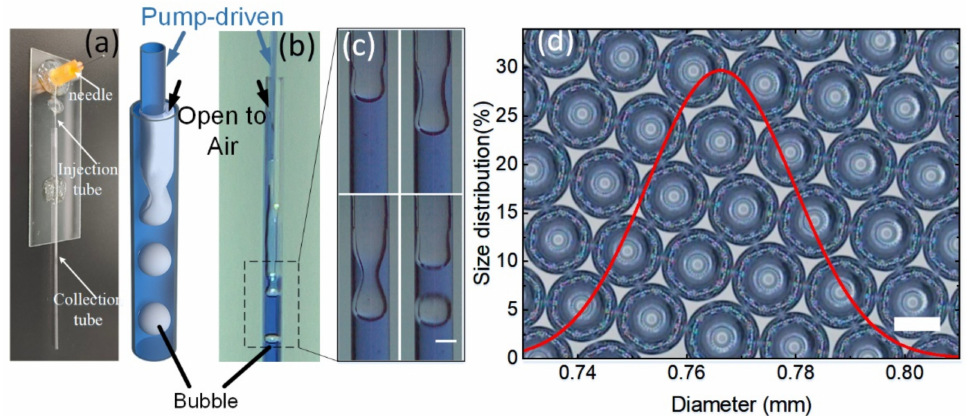
Figure 1. ( a ) Images of the SPFM device; ( b ) schematics illustration and images captured in micro- scopes of the formation of the microbubbles in the SPFM device, which has a typical co-flow structure. However, different from the currently reported co-flow microfluidic method, water was pump-driven into the inner tube, while the collection tube was open to the air, and ( c ) microbubbles were formed downstream in the collection tube; the scale bar is 500 µ m; ( d ) microbubbles prepared in the SPFM device have good monodispersity; the scale bars are 500 µ